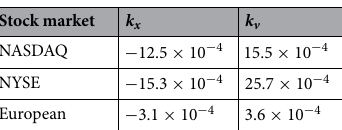
Table 1. Values of the coefficients k x and k v for the three sets of stocks considered.